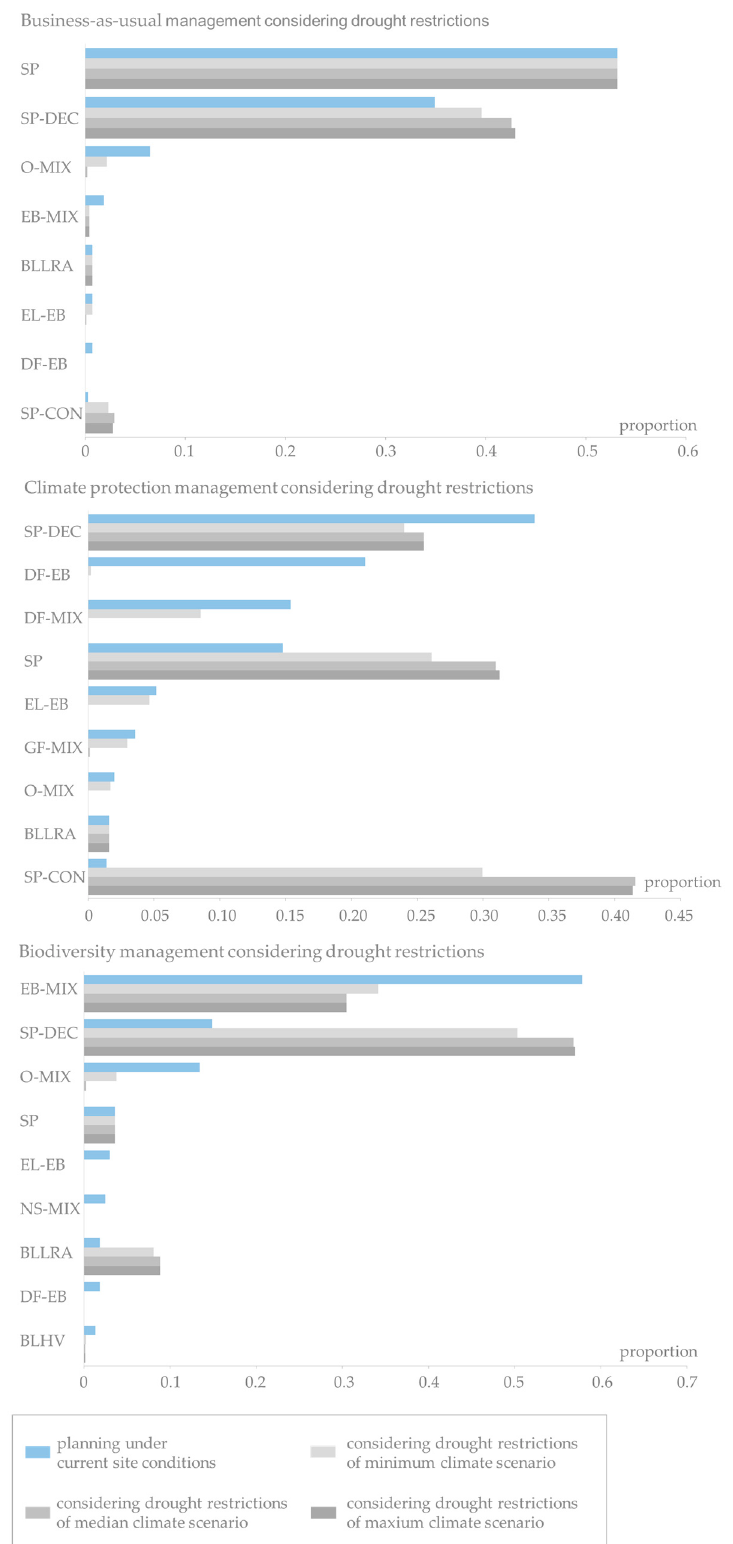
Figure 7. Frequency distribution of succeeding stand type area under constant site conditions in 2070 ( light blue ) and adaptive planning (stage 2) considering drought restrictions under minimum ( light gray ), median ( gray ) and maximum ( dark gray ) climate scenarios under three silvicultural management strategies in Fläming.